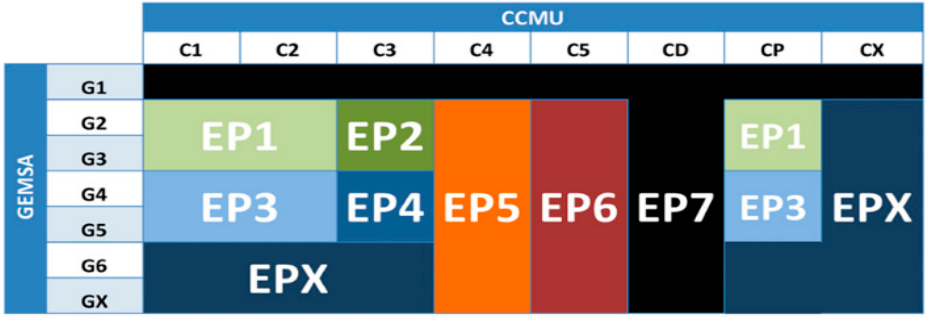
Figure 2. EP classification of ED patients [8].